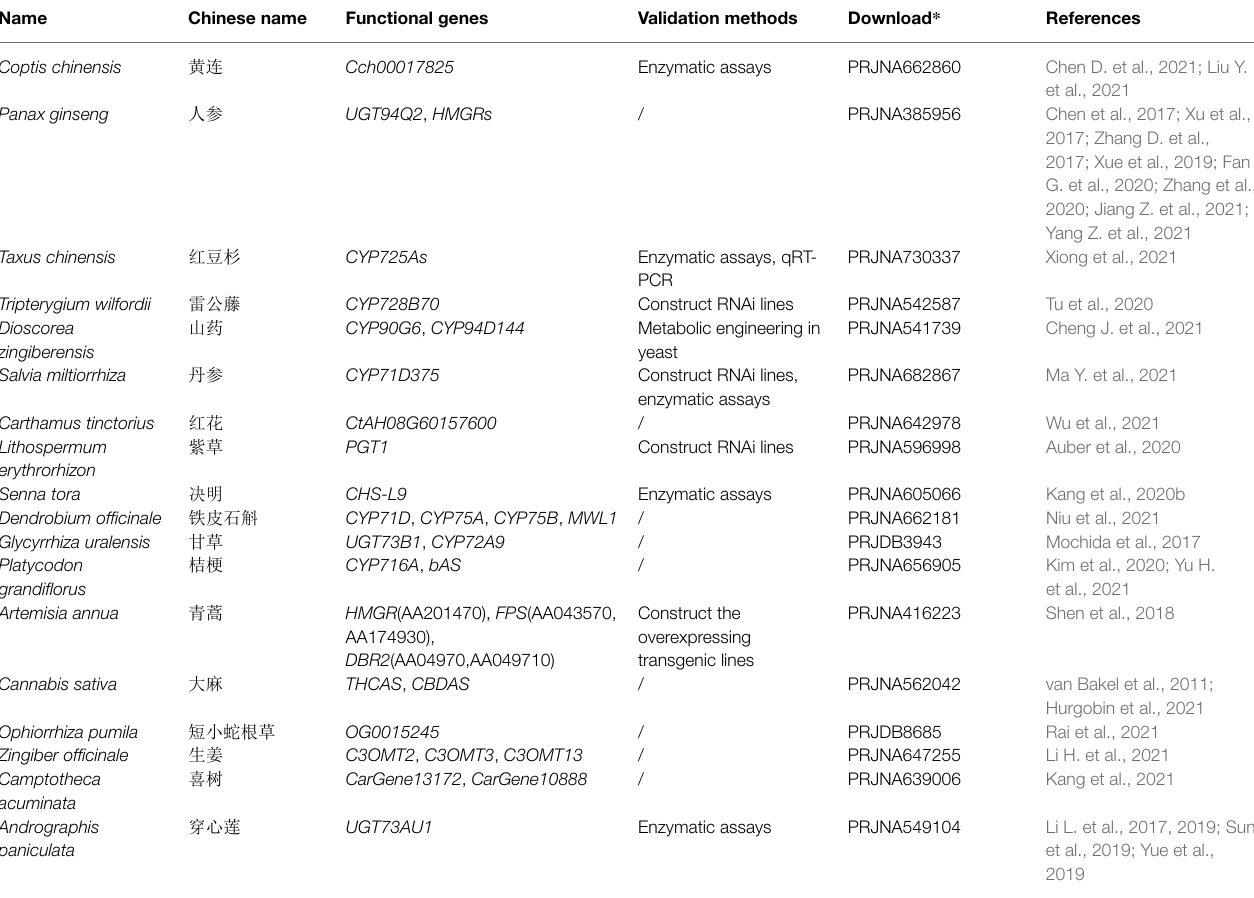
TABLE 1 | Summary of the bioactive compounds related functional genes from the assembly Chinese herbal medicines (CHM)